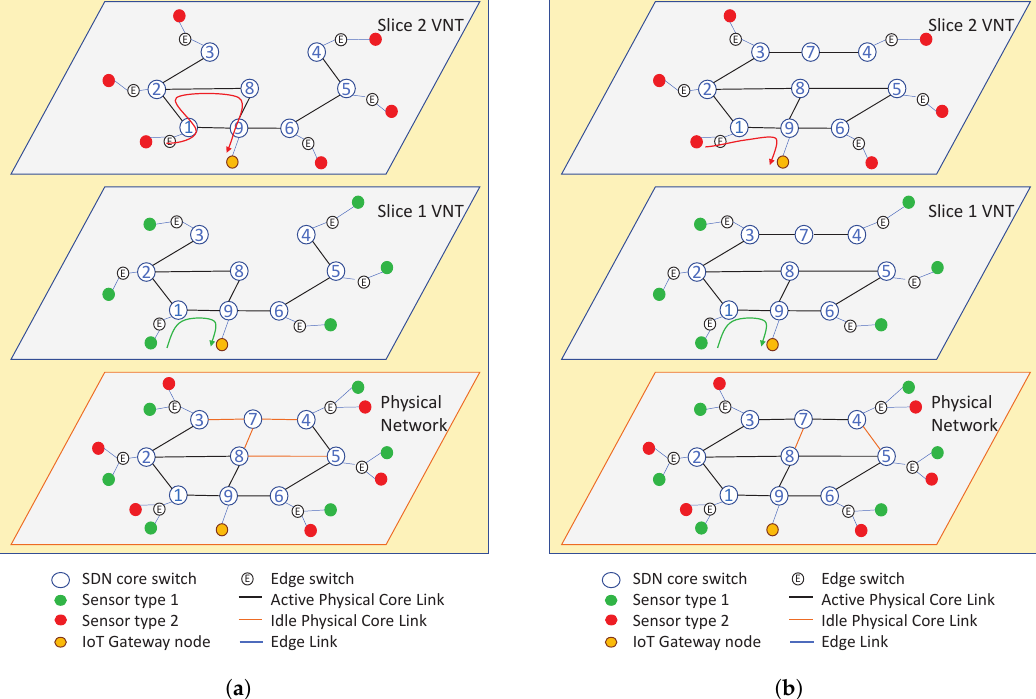
Figure 6. The VNTs in the network slices and the active/idle link configuration in the physical topology optimized for the initial traffic matrix when the crowd was close to ( a ) the edge of core node 1 and ( b ) the edge of core node